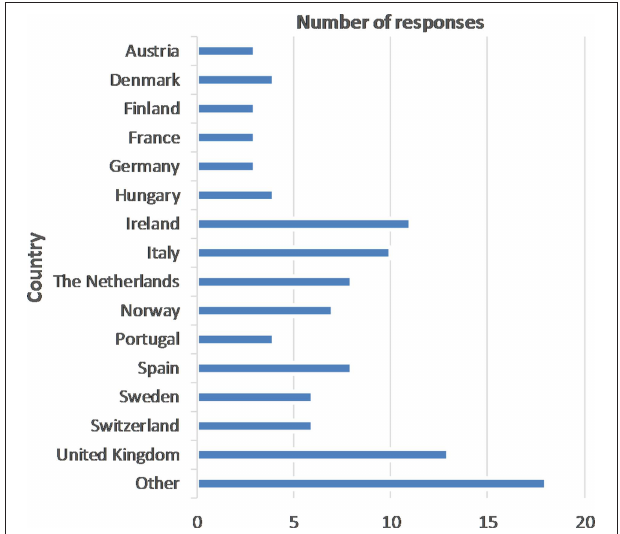
FIGURE 1 | Number of survey responses by